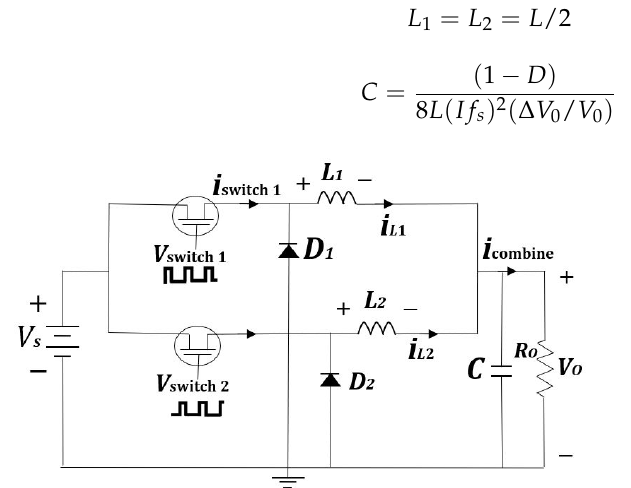
Figure 3. Schematic of an interleaved buck converter for switching current harmonics